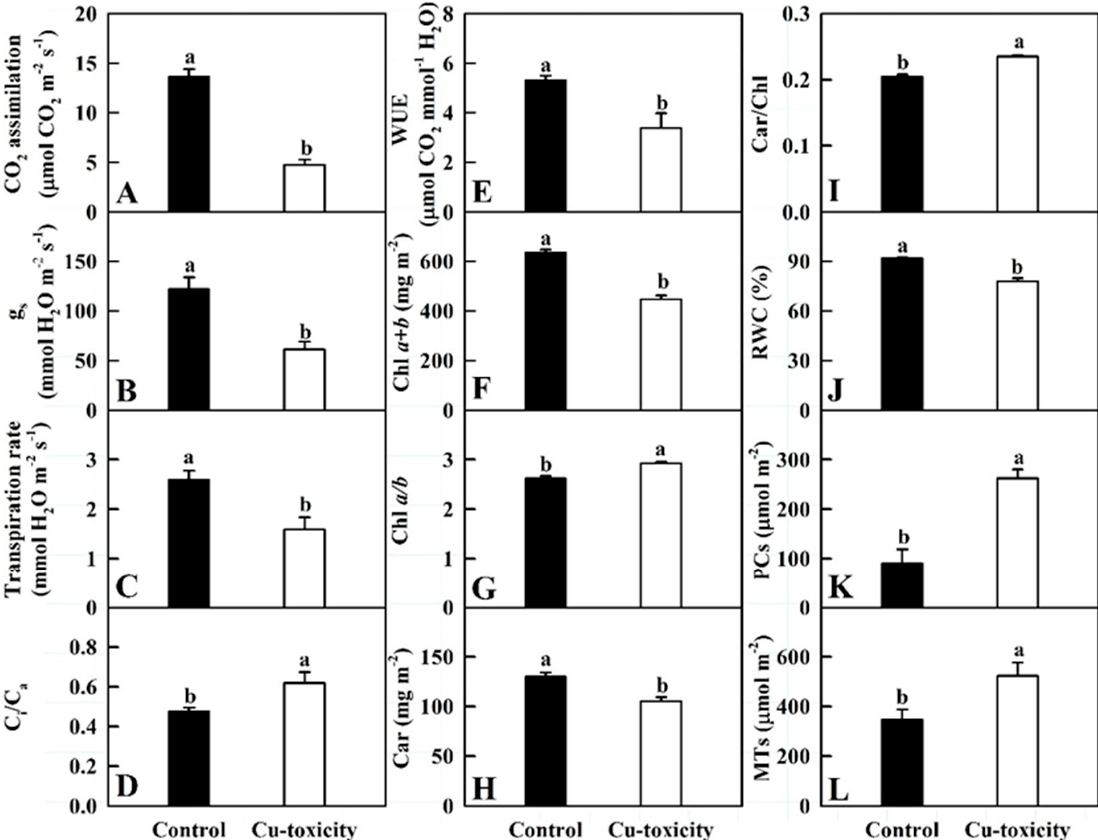
Figure 2. Cu-toxic effects on mean (± SE, n = 7 except for 5 for Chl and Car and 4 for RWC, PCs and MTs) CO 2 assimilation ( A ), stomatal conductance (g s , ( B )), transpiration rate (Tr, ( C )), ratio of intercellular to ambient CO 2 concentration (C i /C a , ( D )), water use efficiency (WUE, ( E )), chlorophyll (Chl) a + b ( F ), Chl a / b ( G ), carotenoids (Car, ( H )), Car/Chl ( I ), relative water content (RWC, ( J )), phytochelatins (PCs, ( K )) and metallothioneins (MTs, ( L )) in leaves. Different letters above the bars indicate a significant difference at p < 0.05.